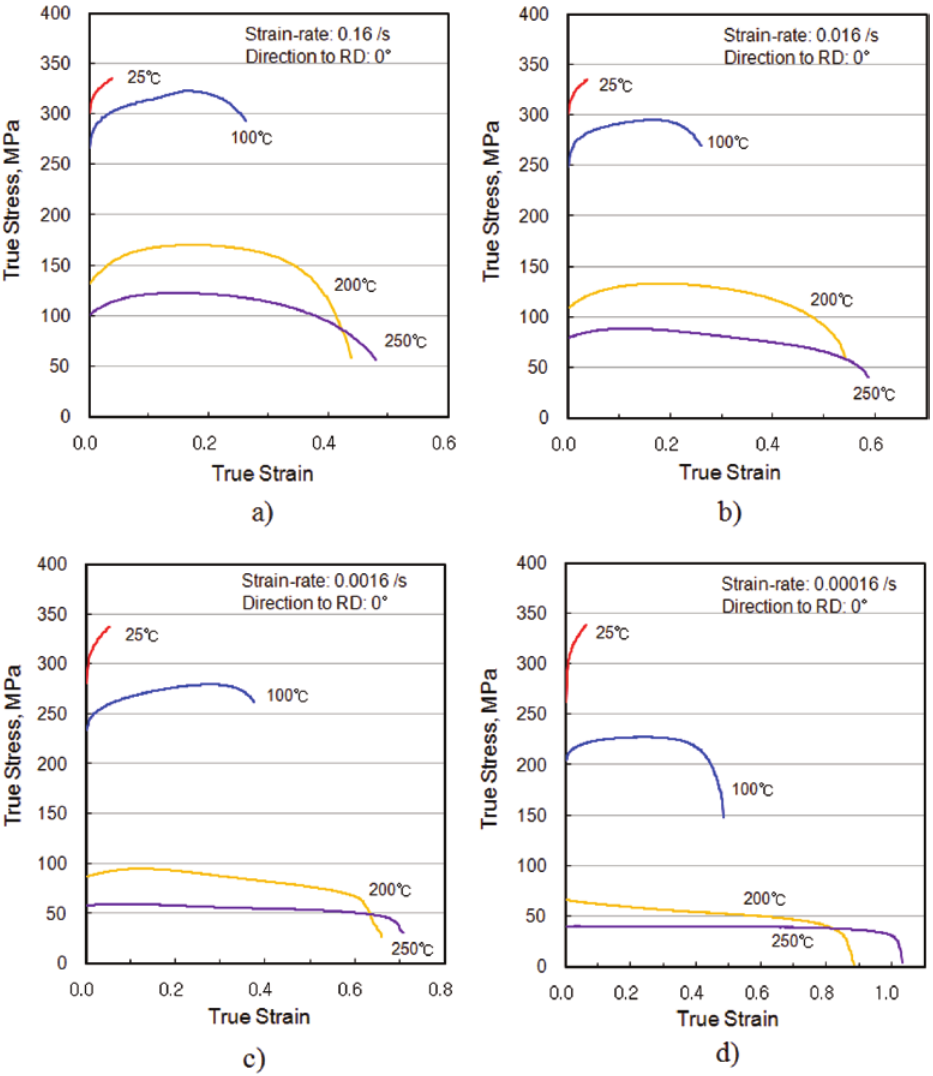
Fig. 1: Stress-strain curves at elevated temperatures and strain rates: (a) 0.16/s, (b) 0.016/s, (c) 0.0016/s, (d) 0.00016/s